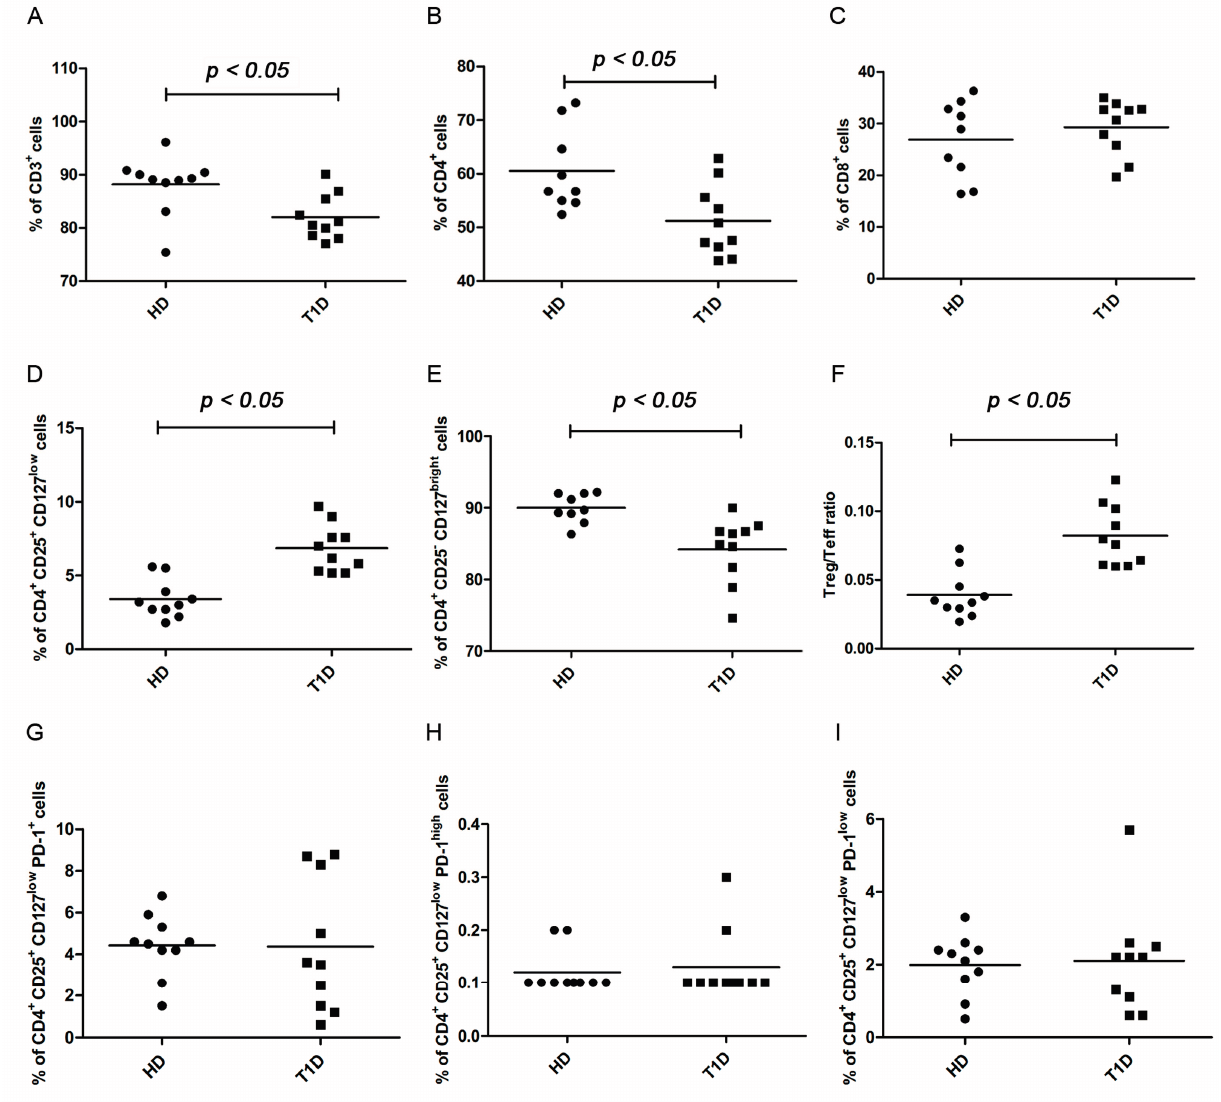
PD-1 high (Figure S3H, Kolmogorov-Smirnov test p < 0.05; Mann Whitney test p = 0.1234) and PD-1 low expressing cells (Figure S3I, Kolmogorov-Smirnov test p > 0.10; unpaired t test with Welch’s correction p = 0.6142).